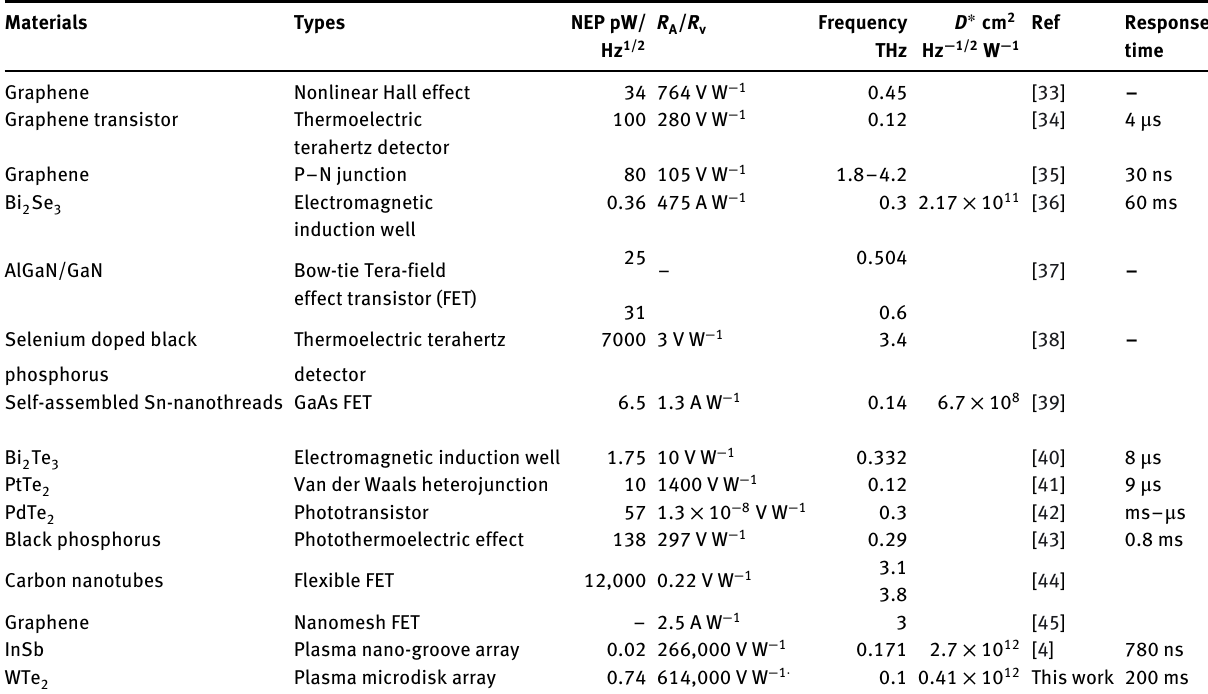
Table 1: THz detectors based on different materials in recent five